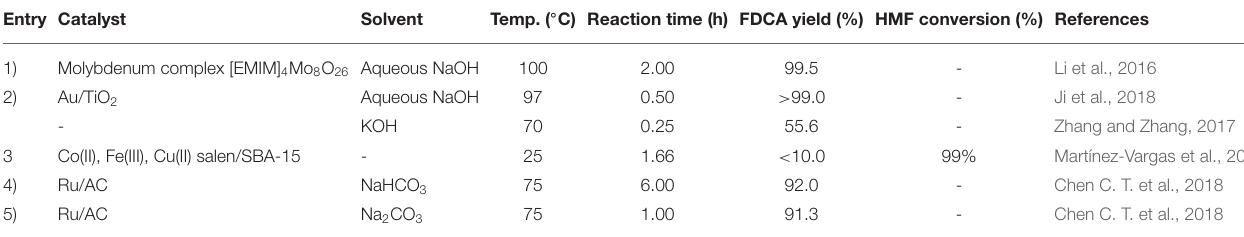
TABLE 4 | HMF oxidation processes to FDCA by using H 2 O 2 as the oxidant. Entry Catalyst